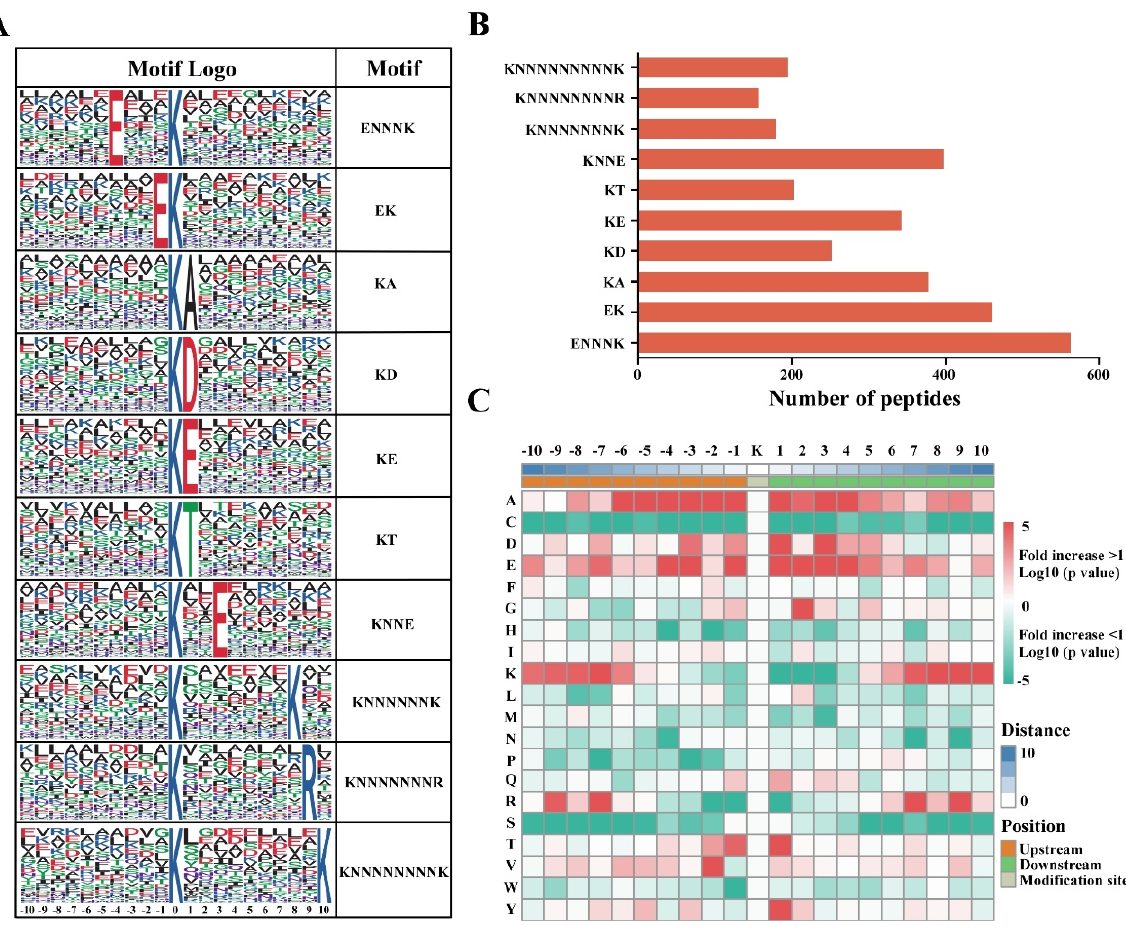
Figure 3. Distribution and characteristics of ubiquitinated lysine motifs and peptides in wheat. ( A ) Identification of ubiquitination motifs and conservative ubiquitination sites in all ubiquitinated peptides. ( B ) Number of ubiquitination motifs on the identified ubiquitinated peptides. ( C ) Amino acid sequences of characteristic ubiquitination sites. The heatmap indicated the expression of significant position-specific amino acids downstream and upstream of the modification sites.